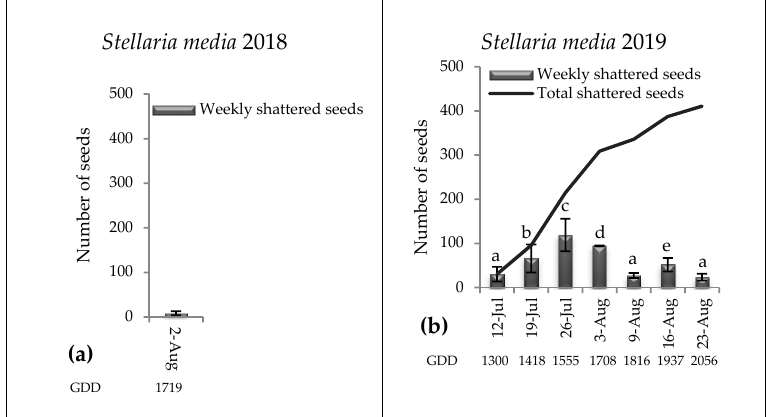
Figure 6. Average weekly and cumulative seed shedding per plant of Stellaria media in ( a ) 2018 and ( b ) 2019 during the growing season of spring oat. GDD = Growth Degree Days = sum of daily mean temperatures above 0 from the date the oat was sown. Columns with different letters are statistically different at the 0.05 probability level.